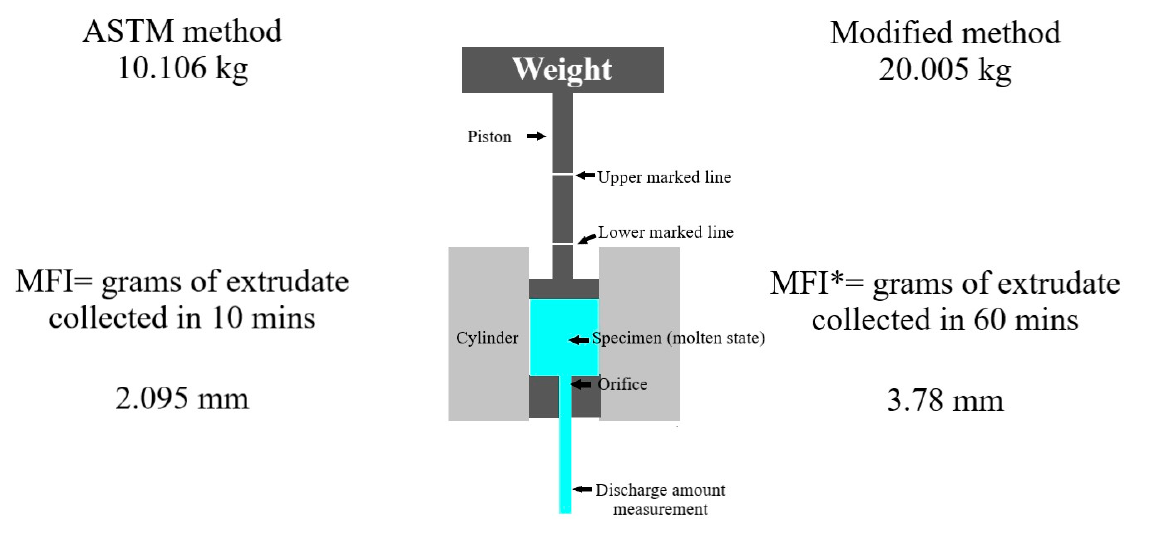
Figure 7. Melt flow index of HPMC HME 4M and HPC GXF using ASTM and modified ASTM method at 160 °C. Melt flow indices obtained from the modified method were used to compare ease of extrudability and plasticity of HPMC HME 4M and HPC GXF. Table 6. Melt flow index of HPC GXF and HPMC HME 4M at 160 °C using modified ASTM method.